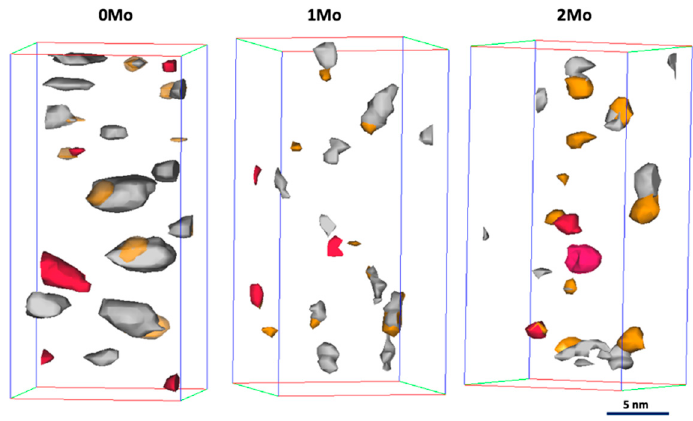
Figure 3. APT reconstructions after aging at 475 °C for 4 h. Cu-rich precipitates are shown in orange, Ni-rich precipitates containing more than 5 at.% Si ( γ '-Ni 3 (Ti, Al, Si)) in red and less than 5 at.% Si ( η -Ni 3 (Ti, Al)) in grey. Table 2. Composition of the two types of Ni-rich precipitates after aging for 4 h at 475 °C (at.%).